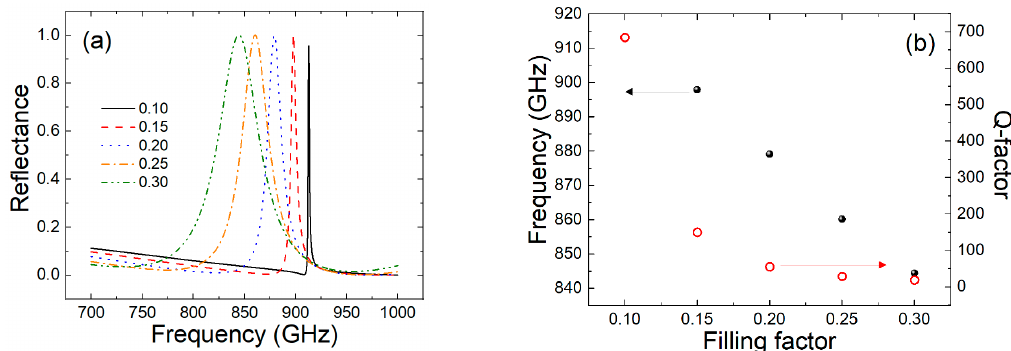
Figure 5. ( a ) Scheme of the simulated THz reflectance with size dependency of the grating layer, where n eff = 2.05; ( b ) peak frequency and Q-factor for the circular pattern.